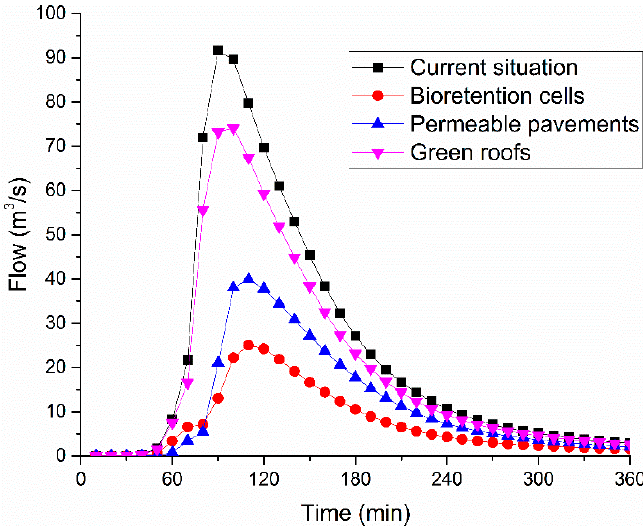
Figure 7. Outlet flow process under P = 1 rainfall.